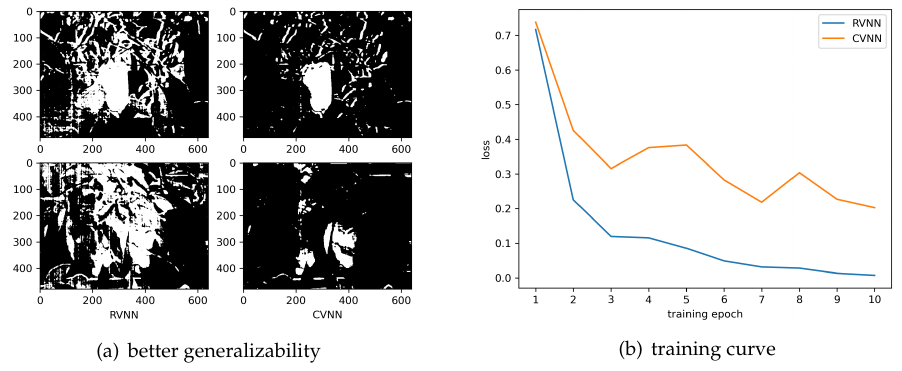
Figure 4. ( a ) shows that CVNN can learn better generalization characteristics of the data to prevent overfitting, and ( b ) reflects this fact by training